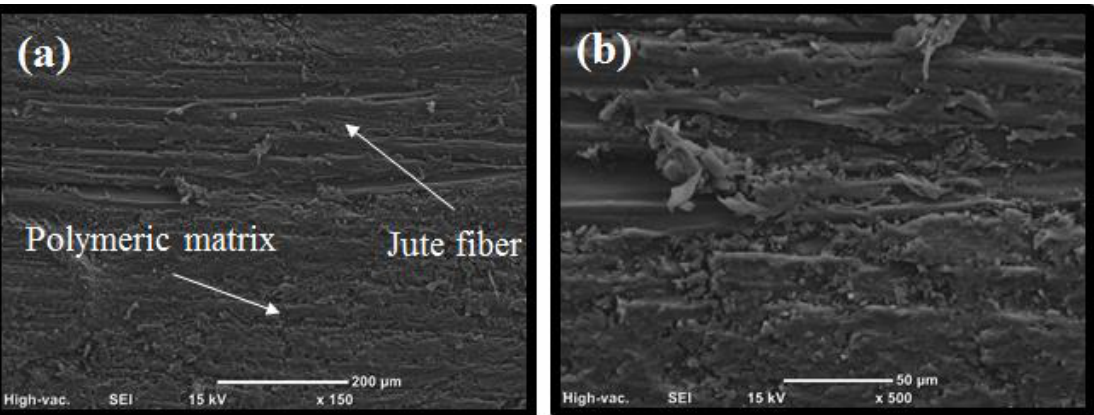
Figure 7. SEM micrographs of the transverse cut of the composite SH WJF40, ( a ): at 150 magnifica- tions and ( b ) at 500 magnifications. and ( b ) at 500